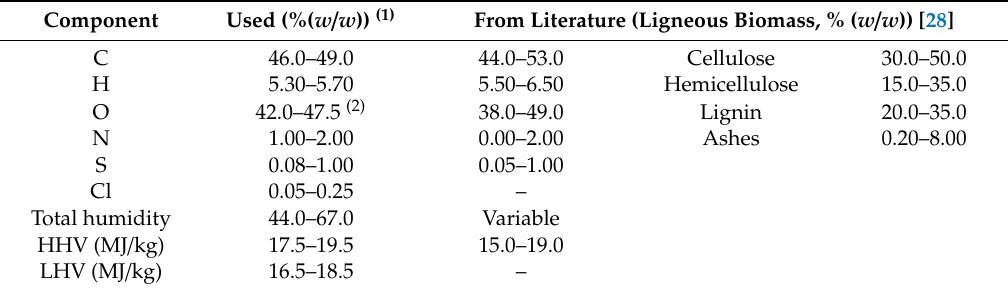
Table 1. Elemental composition, humidity and heating values of cork / eucalyptus bark solid biomass samples. Component Used (%( w / w )) (1) From Literature (Ligneous Biomass, % ( w / w )) [28]